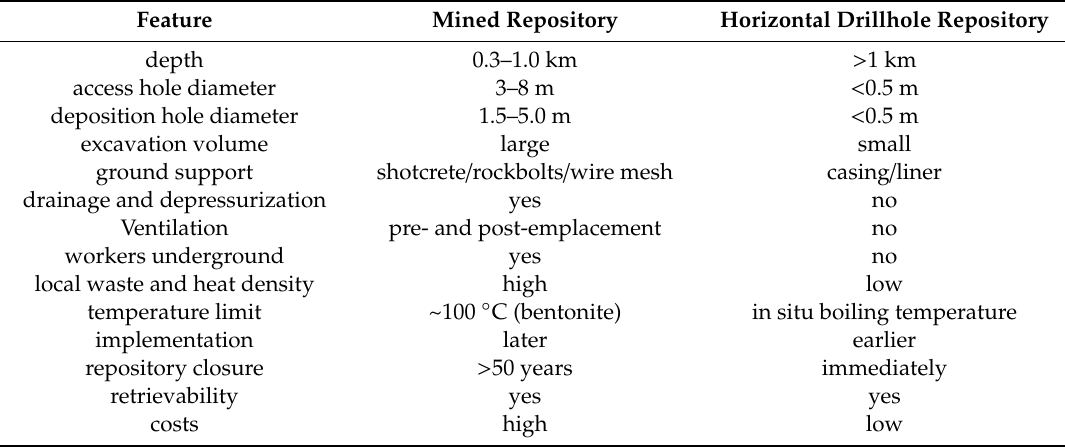
Table 2. Comparison between a minded repository and the proposed deep horizontal drillhole